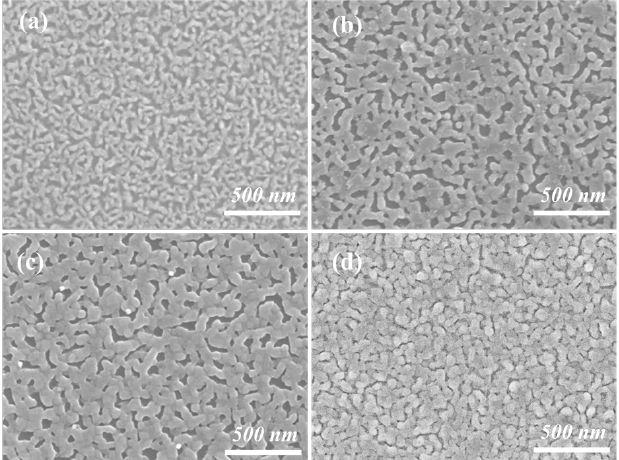
Figure 2. (Color online) The SEM micrographs of the LCO/STO thin films annealed at different temperatures: ( a ) 500 °C, ( b ) 600 °C, ( c ) 700°C, and ( d ) 900 °C, respectively.